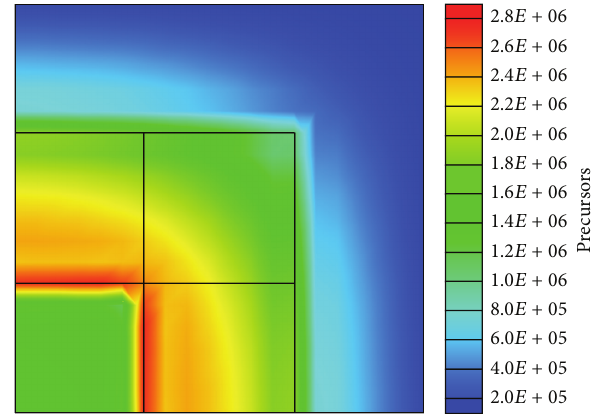
Figure 5: Precursor concentration in TWIGL problem in steady state.